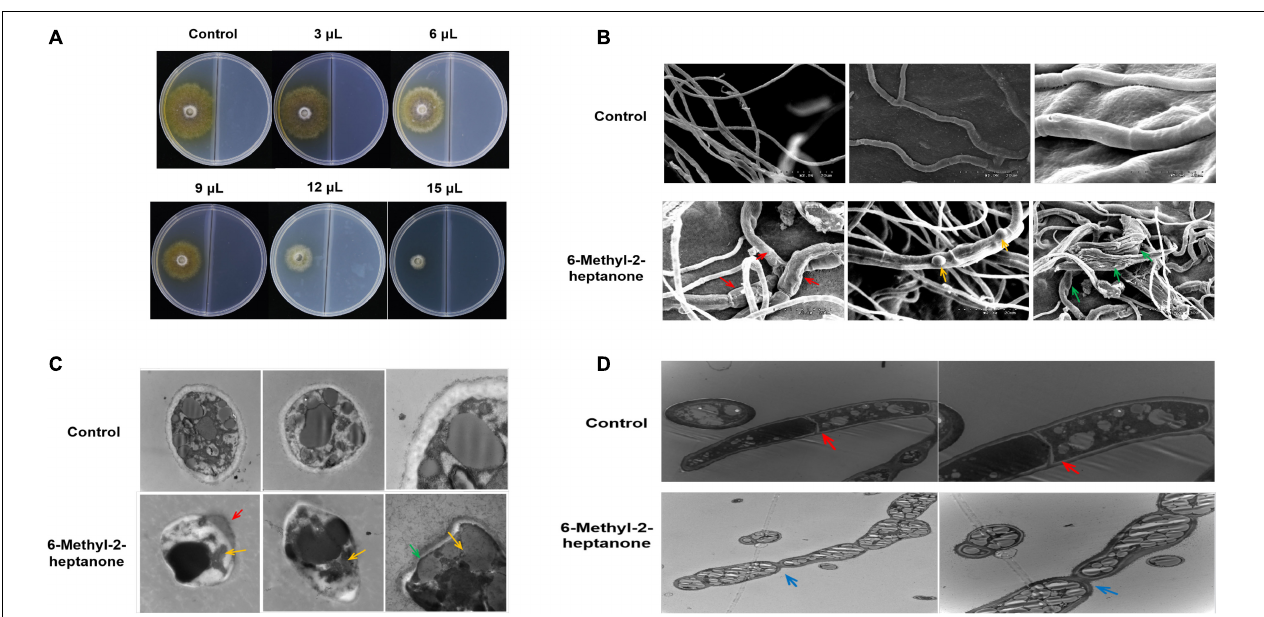
FIGURE 2 | Mycelial growth of A. solani after the 6-methyl-2-heptanone treatment in vitro . A 5-mm square plug of an A. solani mycelial agar disc was placed in one compartment of the divided plate containing PDA medium, and the other compartment containing PDA medium was incubated with different aliquots of pure 6-methyl-2-heptanone. (A) Antagonistic effects of five different doses (3, 6, 9, 12, and 15 µ L) of 6-methyl-2-heptanone against A. solani mycelia. (B) Scanning electron micrographs of A. solani co-cultured with 6-methyl-2-heptanone. The “red arrows” represented wrinkled surface cells of hyphae treated with 6-methyl-2-heptanone; the “yellow arrows” represented swelling tissues on the surface of hyphae after exposure to 6-methyl-2-heptanone; “green arrows” represented 6-methyl-2-heptanone-treated mycelia deformed and significantly enlarged. (C, D) . Transmission electron micrographs of A. solani hyphae co-cultured with 6-methyl-2-heptanone. The “green arrows” represented thinner cell walls; “red arrows” represented the movement of the cytoplasmic content towards the ruptured cell walls or cytoplasmic membranes; “yellow arrows” represented shrunken cytoplasm and decreased number of inclusions in Figure 2C . The “red arrows” represented clear septa in hyphae from the control groups; the “blue arrows” represented hyphae with wrinkled obviously at the septa after exposure to 6-methyl-2-heptanone in Figure 2D .